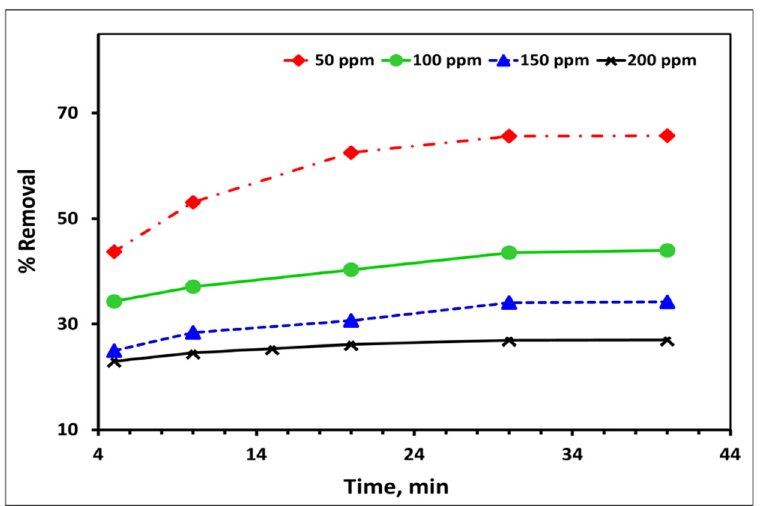
Figure 5. Effect of contact time on the % removal of cobalt by ZrO 2 NPs570 ( λ = 667, Volume: 50 mL, Conc.: 50–200 ppm, pH: 6.5, ZrO 2 mass: 0.3 g).